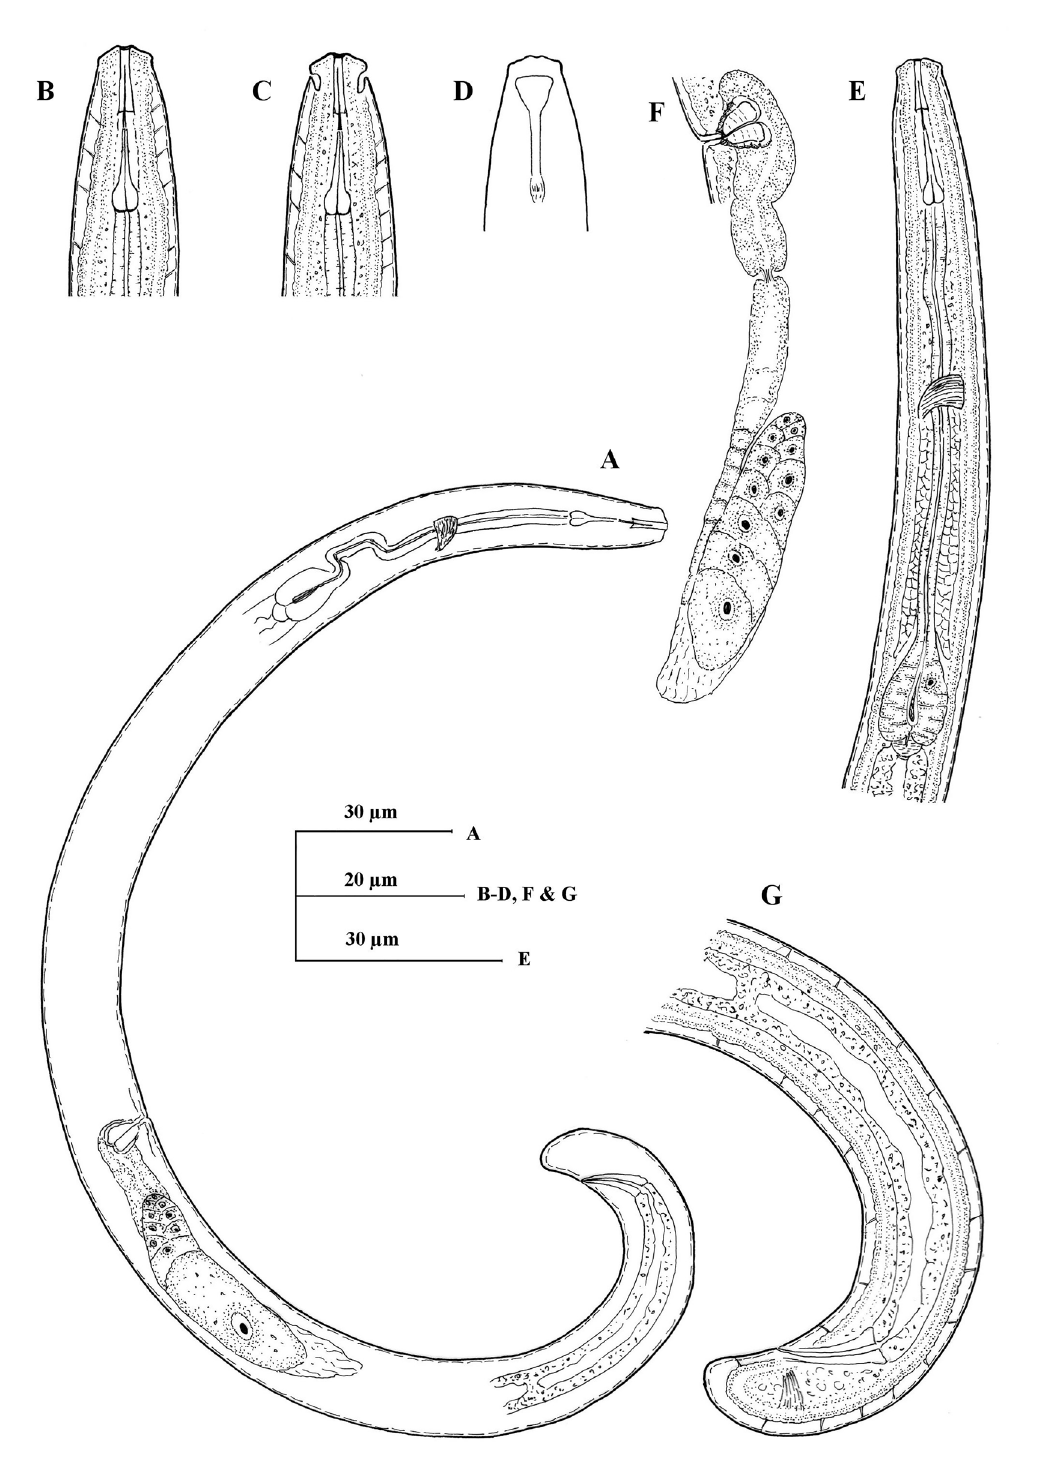
Fig. 16. Basirotyleptus siddiqii sp. nov., ♀. A–B, D–G . Holotype (AMU/ZD/NC/ Basirotyleptus siddiqii /1). C . Paratype 1 (AMU/ZD/NC/ Basirotyleptus siddiqii /2). A . Entire specimen. B–C . Anterior region. D . Anterior region showing amphid. E . Pharyngeal region. F . Genital system. G . Posterior